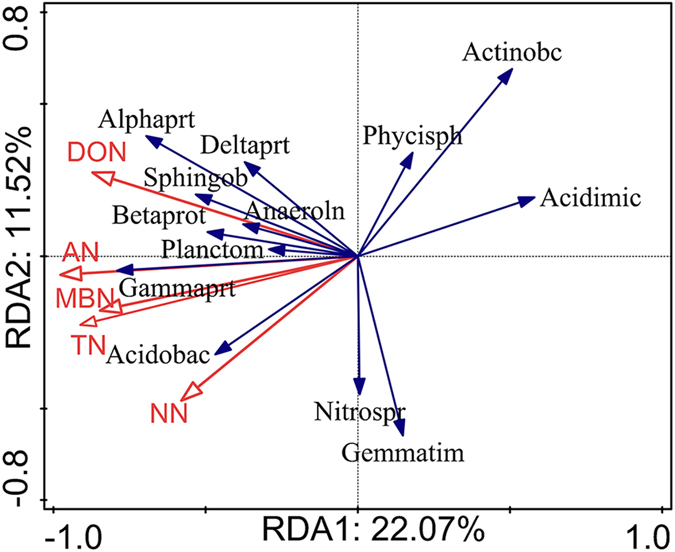
RDA analysis between soil N fractions and soil bacterial class following afforestation.The abbreviation were as follow: Actinobacteria (Actinoba), Acidobacteria (Acidobac) Alphaproteobacteria (Alphapro), Planctomycetacia (Planctom), Gammaproteobacteria (Gammapro), Betaproteobacteria (Betaprot), Deltaproteobacteria (Deltapro), Gemmatimonadetes (Gemmatim), Acidimicrobiia (Acidimic), Sphingobacteriia (Sphingob), Nitrospira (Nitrospi), Anaerolineae (Anaeroli), Phycisphaerae (Phycisph).